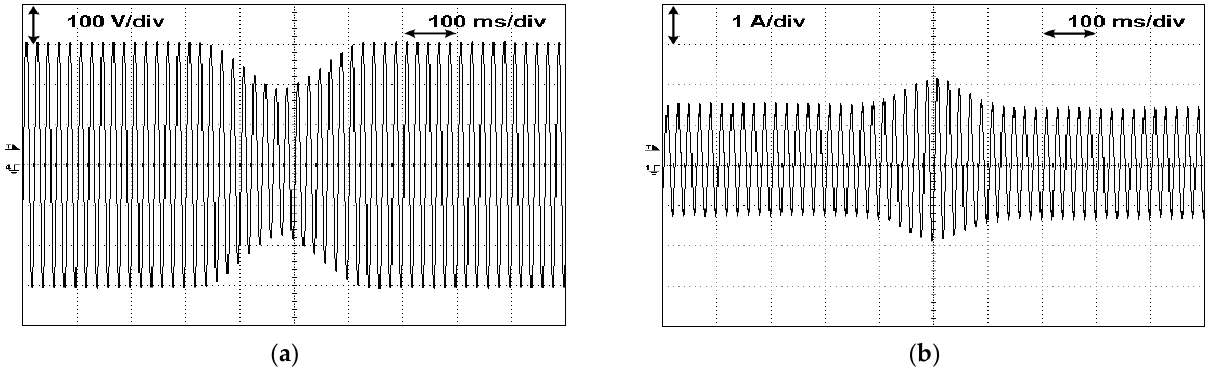
Figure 9. Test with a voltage sag: ( a ) output testing system voltage ( b ) current injected by the PV system.